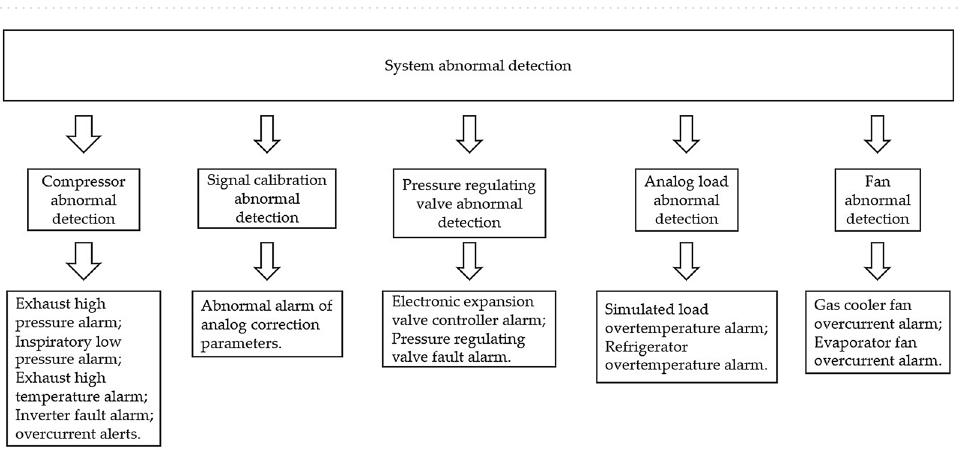
Figure 13. The system abnormal detection